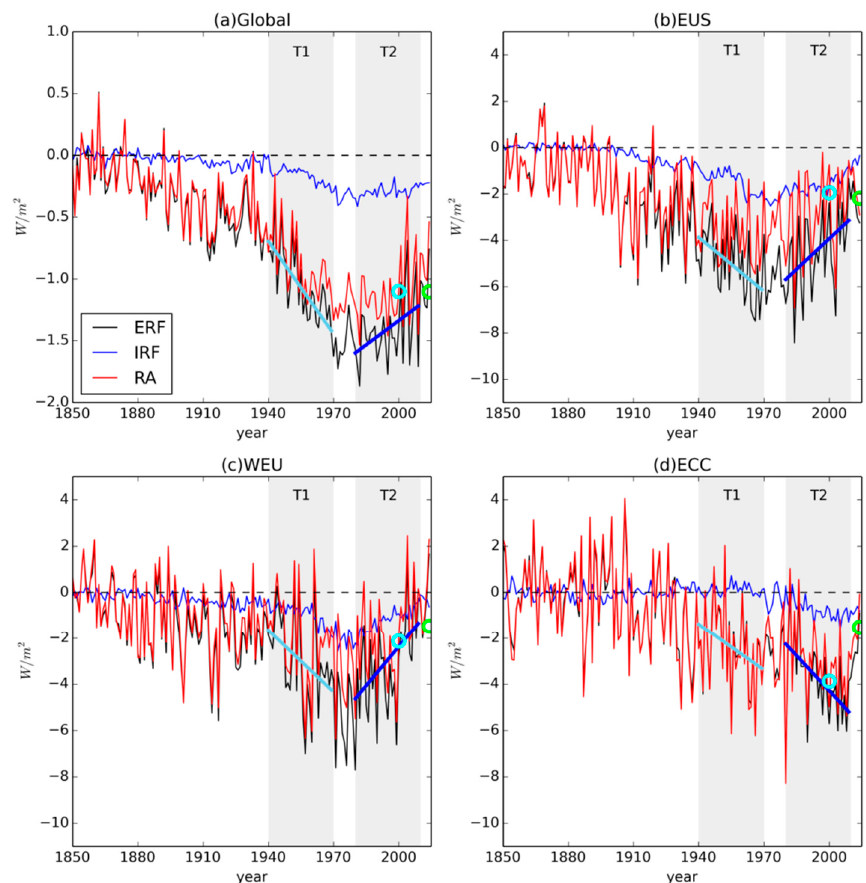
Figure 3. Global ( a ) and regional ( b – d ) means of e ff ective radiative forcing (ERF), instantaneous radiative forcing (IRF), and rapid adjustment (RA) over the historical period (1850–2014) estimated by transient simulations ( ERF trans ) with grey shade indicating analysis periods T1 (1940–1970) and T2 (1980–2010). Solid lines indicate the trends of ERF in T1 (1940–1970) and T2 (1980–2010) periods with cyan and green colored circles indicating ERF for 2010 in CMIP5 and 2014 in the Coupled Model Intercomparison Project 6 (CMIP6) calculated from the equilibrium run ( ERF fsst ).